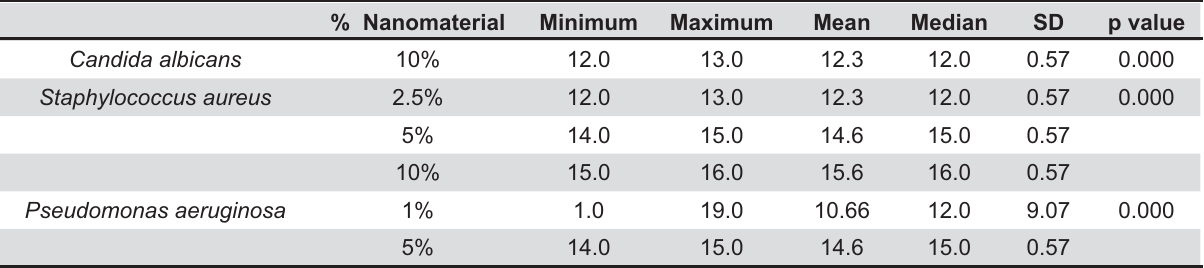
Table 2- Descriptive